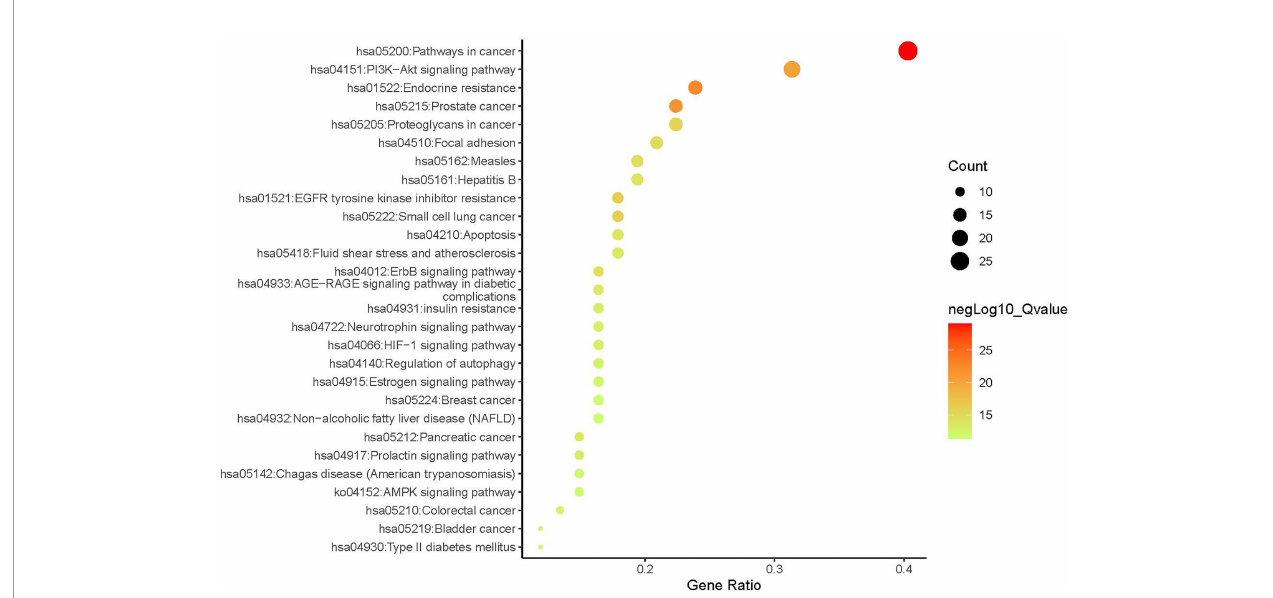
FIGURE 4 | The Enrichment plot of KEGG pathway analysis. The size and color of nodes represent the count and – log10(q) values of pathways.